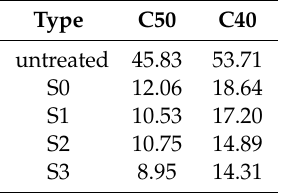
Figure 5. E ff ect of SiO 2 sol / silane emulsion with di ff erent programs on water absorption amount in Figure 5. Effect of SiO 2 sol/silane emulsion with different programs on water absorption amount in concrete: ( a ) C50; ( b ) C40. concrete: ( a ) C50; ( b ) C40. Table 4. The capillary water absorption coe ffi cients of concrete [g.m − 2 h − 0.5 Table 4. The capillary water absorption coefficients of concrete [g.m − 2 h − 0.5 ].